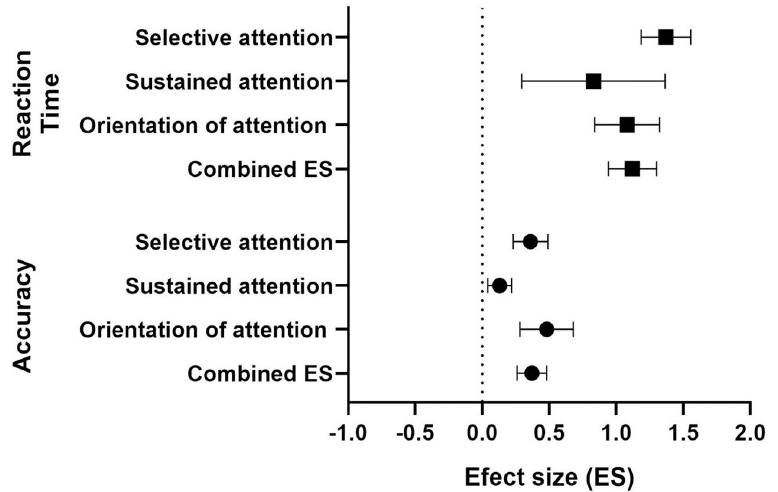
Fig 5. Forest plot showing subgroup analysis of different the components of visual attention. Forest plot of combined effect size, 95%CI, for accuracy and reaction time for selective visual attention, sustained visual attention, and the orientation of visual attention.